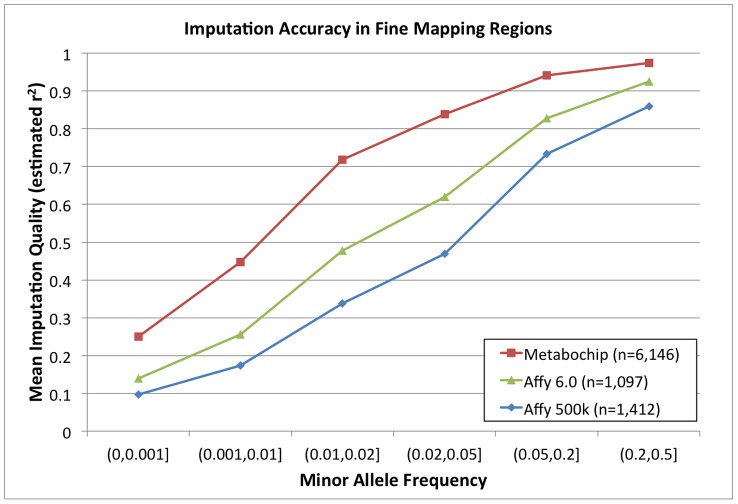
Imputation accuracy (estimated r2) in fine mapping regions.Imputation accuracy for differing numbers of Sardinian individuals as measured by estimated r2 value across the 257 Metabochip fine mapping regions for Metabochip (red squares), Affymetrix 6.0 GWAS SNPs (green triangles), and Affymetrix 500 k GWAS SNPs (blue circles) as a function of minor allele frequency bin.